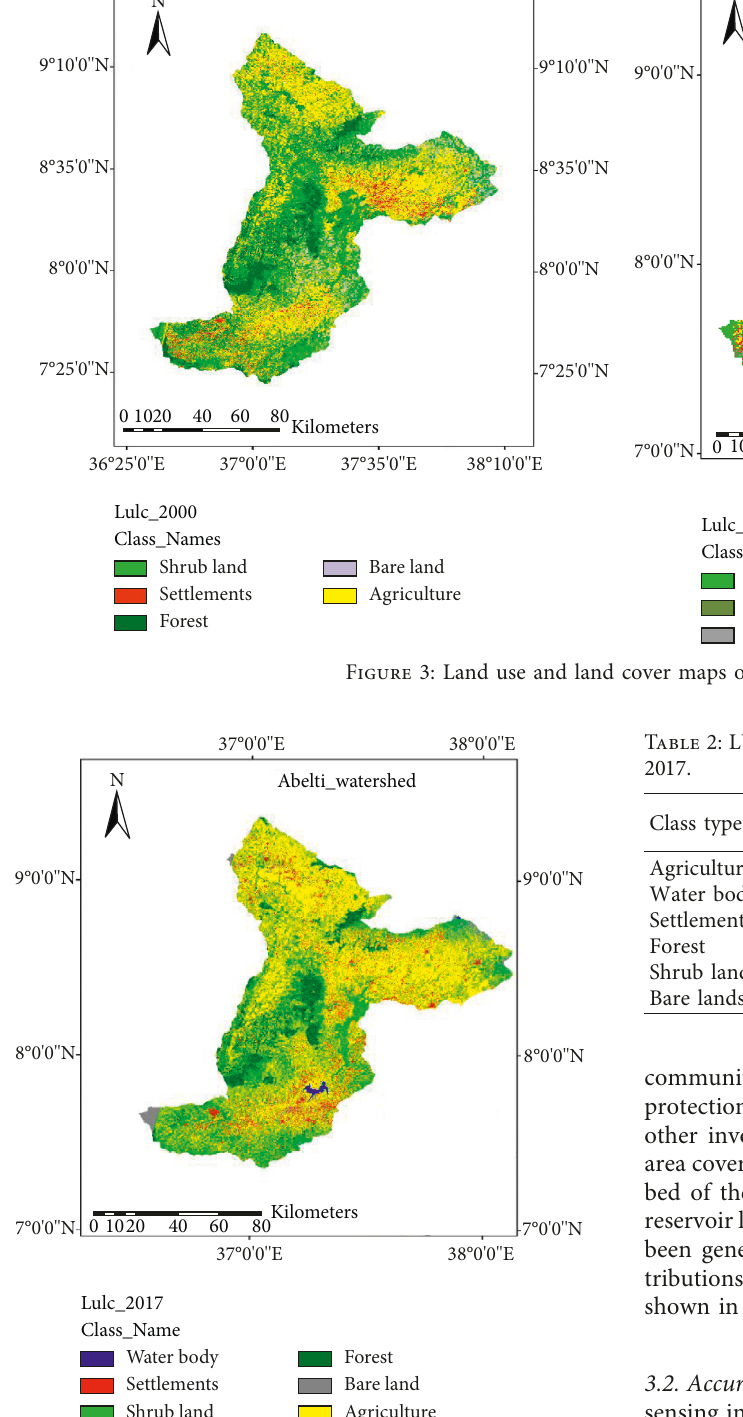
Figure 4: Land use and land cover maps of 2017.